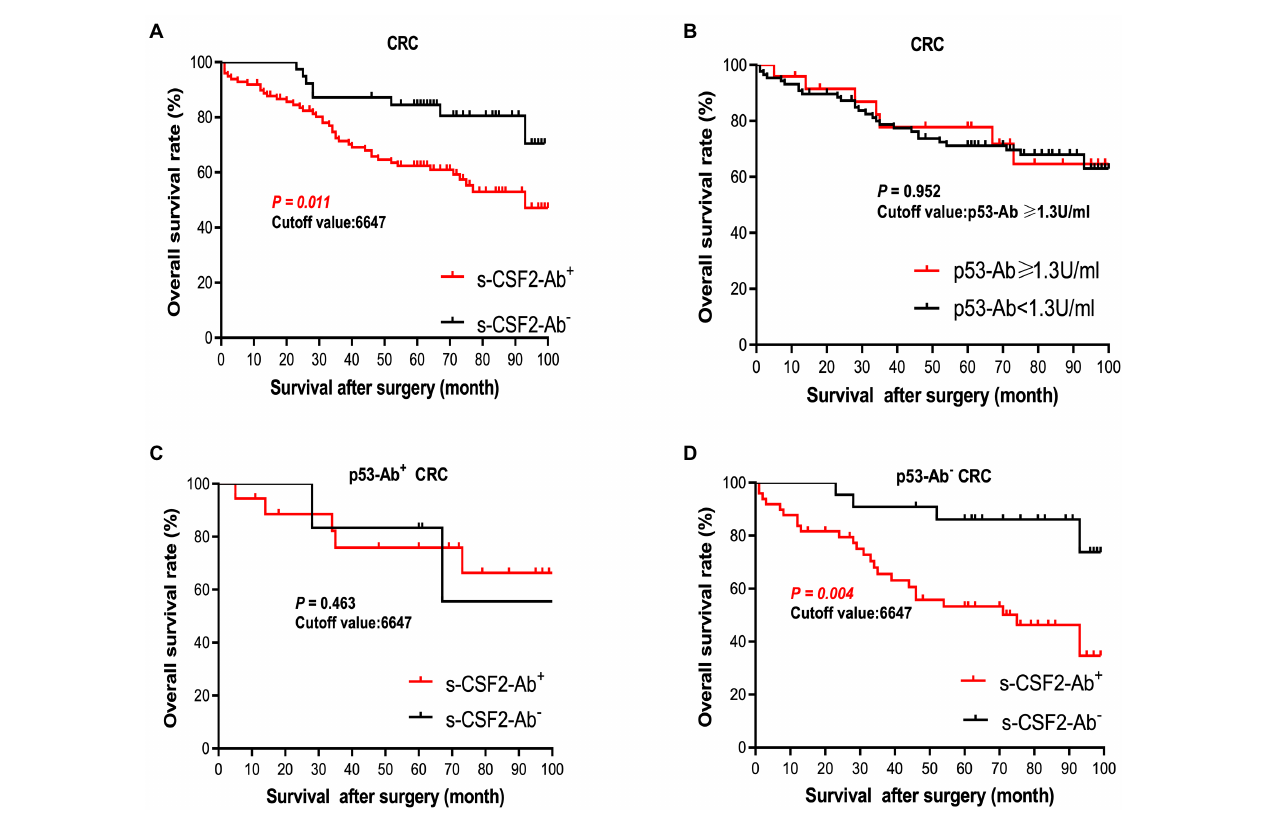
FIGURE 6 Comparison of survival according to s-CSF2-Ab positivity in patients with CRC after surgery. ( A ) Comparison of the postoperative survival between the s-CSF2-Ab + and s-CSF2-Ab − patients with CRC ( P = 0.011). ( B ) Comparison of the overall survival between the p53-Ab + ( ≥ 1.3 U/ml) and p53-Ab − (<1.3 U/ml) patients with CRC ( P = 0.952). ( C ) Comparison of the overall survival between the s-CSF2-Ab + and s-CSF2-Ab − patients with CRC among those with p53-Ab ≥ 1.3 U/ml ( P = 0.463). ( D ) Comparison of the overall survival between the s-CSF2-Ab + and s-CSF2-Ab − patients with CRC among those with p53-Ab <1.3 U/ ml ( P = 0.004). The cutoff values in patients with CRC were determined via the ROC analysis presented in Figure 5D. Statistical analyzes were performed by the Log-Rank test between two